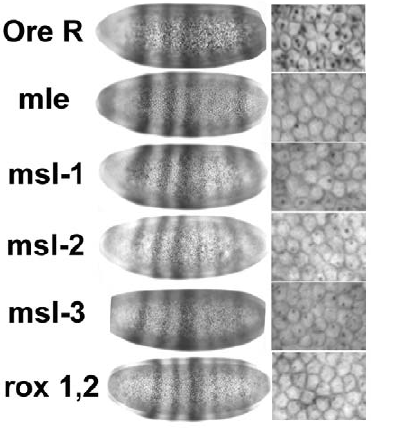
Figure 6. Reduced in situ signal in Sxl is not accompanied by reduced signal in another unrelated gene. In situs for Sxl Pm transcripts performed simultaneously with the segmentation gene hairy . Embryos from msl mothers show the normal hairy striping pattern of expression for the same developmental stage as Ore R embryos (left set of panels), but poor Sxl Pm signal (right set of panels—enlarged view to show cells). All embryos photographed at 40 6 mag.